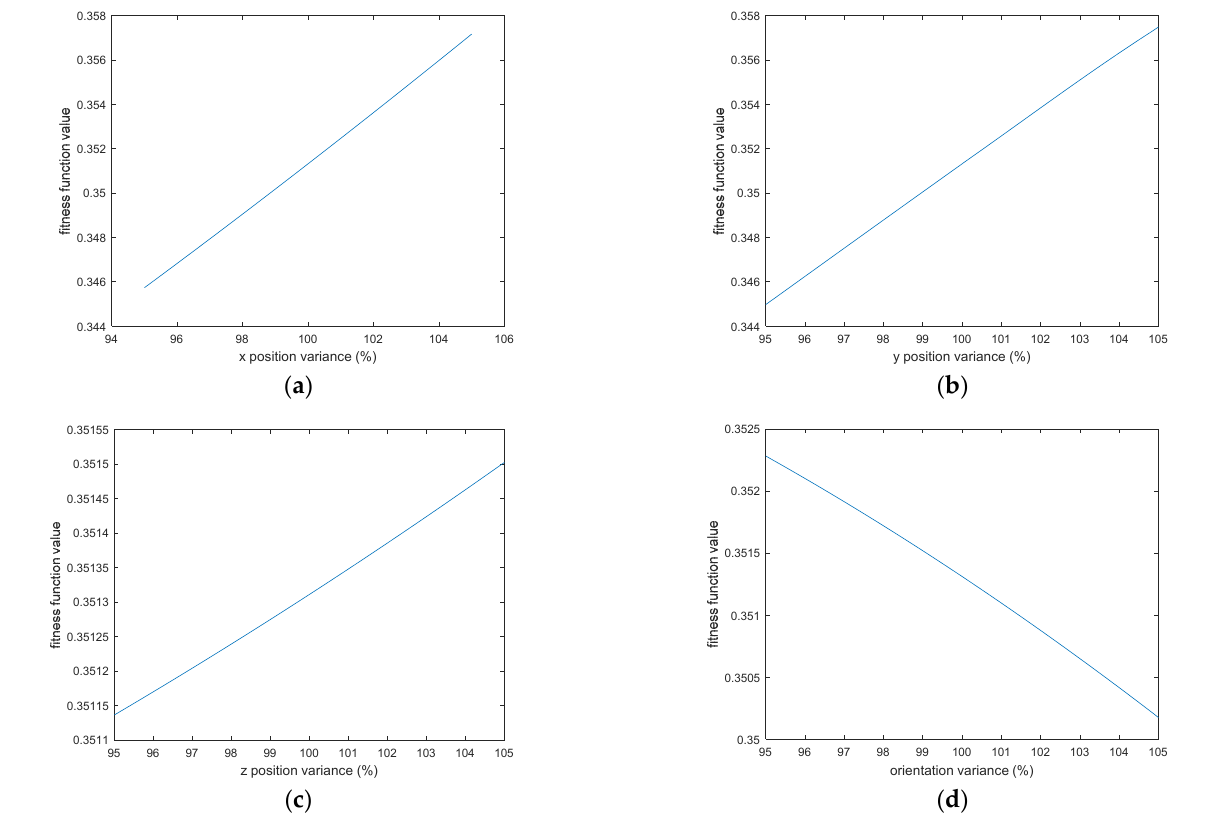
4. Experimental Setup The task optimal location experiment was performed at the robotic stand of the Ro ‐ botic Systems Lab., Bialystok University of Technology (BUT), Bia ł ystok, Poland. The